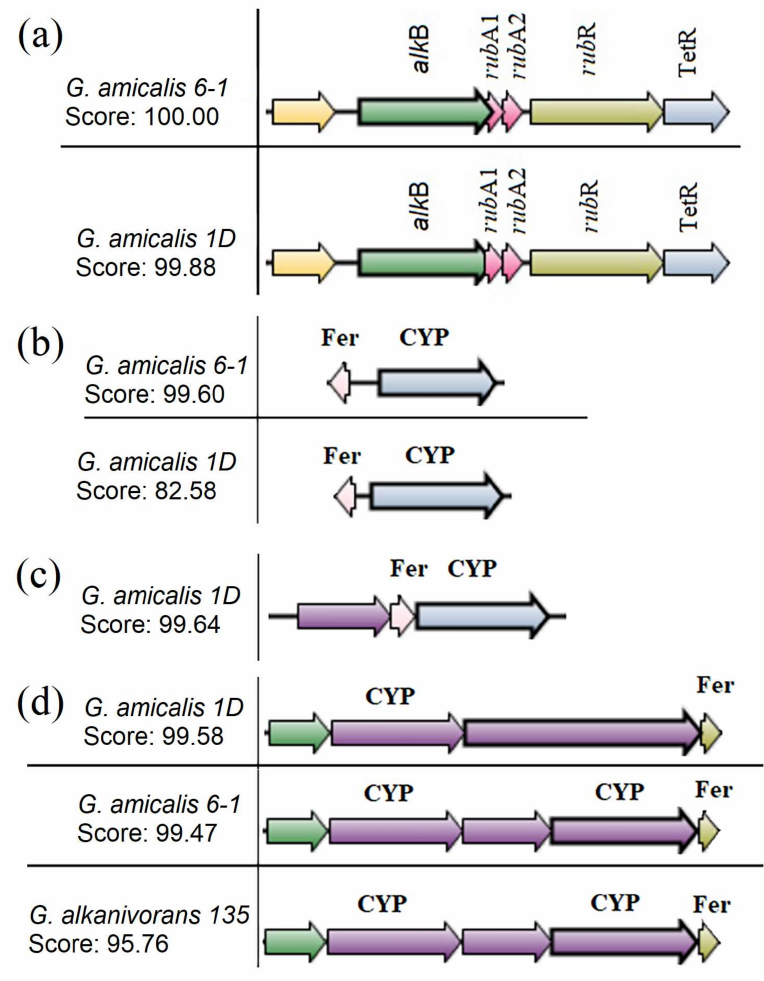
Figure 4. Comparative structure of the genomic clusters encoding alkane hydroxylases AlkB ( a ) and CYP153 ( b – d ) families in Gordonia strains. Designation: ( b ) strains 6-1 (UPW14530.1) and 1D (ATD70990.1): ferredoxin, cytochrome P450; ( c ) strain 1D (ATD69356.1): oxidoreductase,